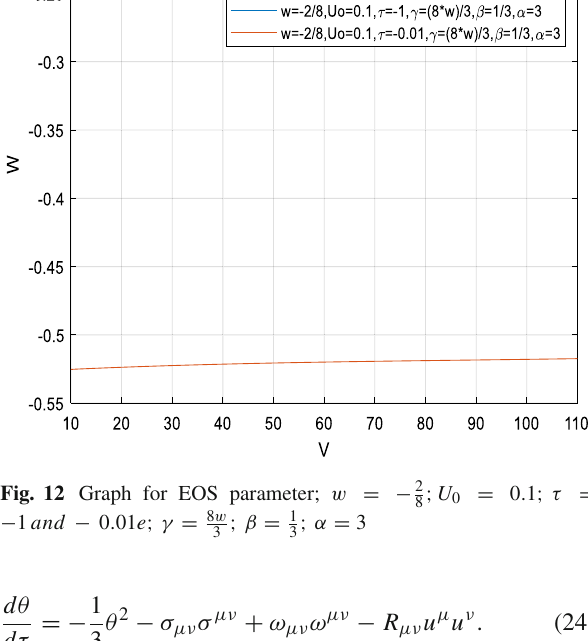
Fig. 11 Graph for pressure; w = − 2 ; β = 1 ; α = 3 8 w 3 3